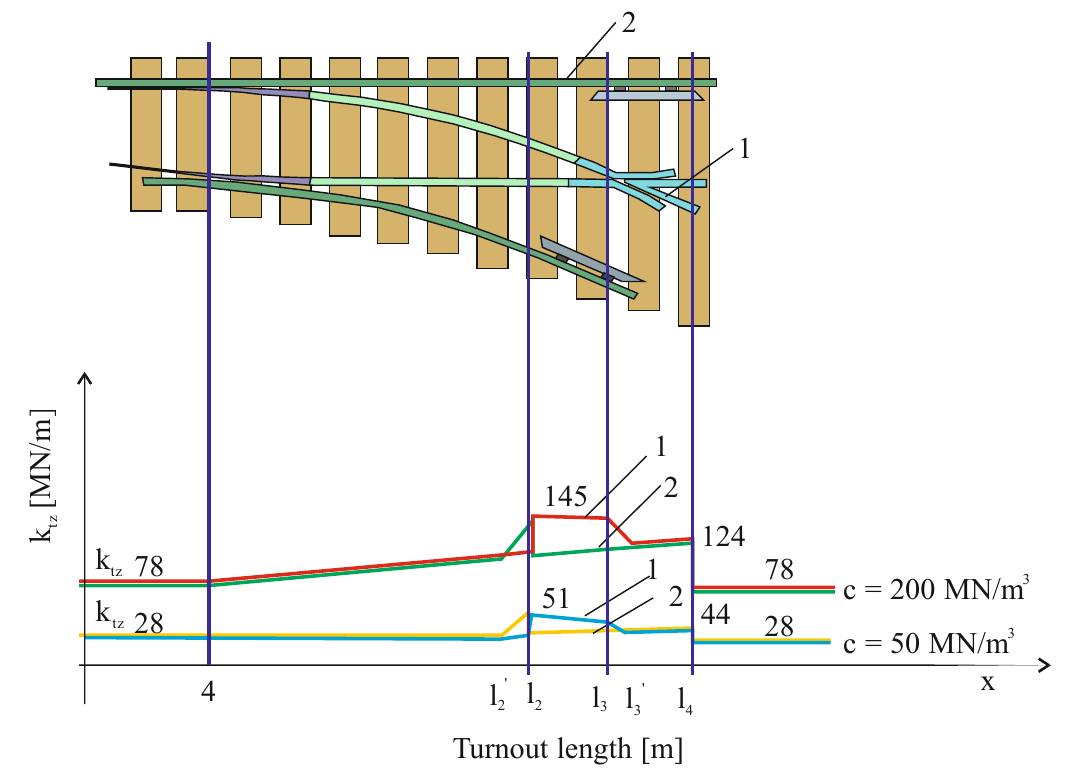
Figure 5 . The course of variation of the vertical stiffness coefficient of the rails in the switch with different values of the bedding coefficient (real measurements on CMK Idzikowice): 1—Inner track (with cross-brace), 2—Outer track [18].